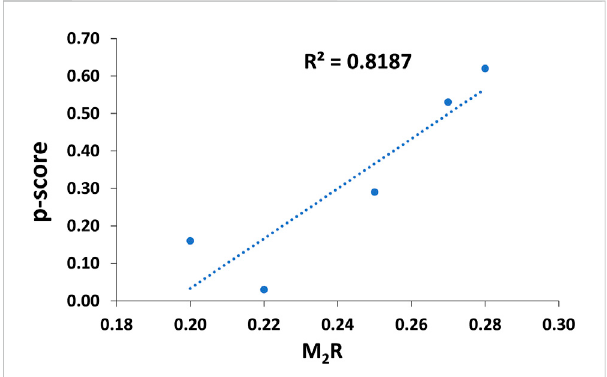
FIGURE 9 Coef fi cient of determination between empirical-based p-score and computed M 2 R